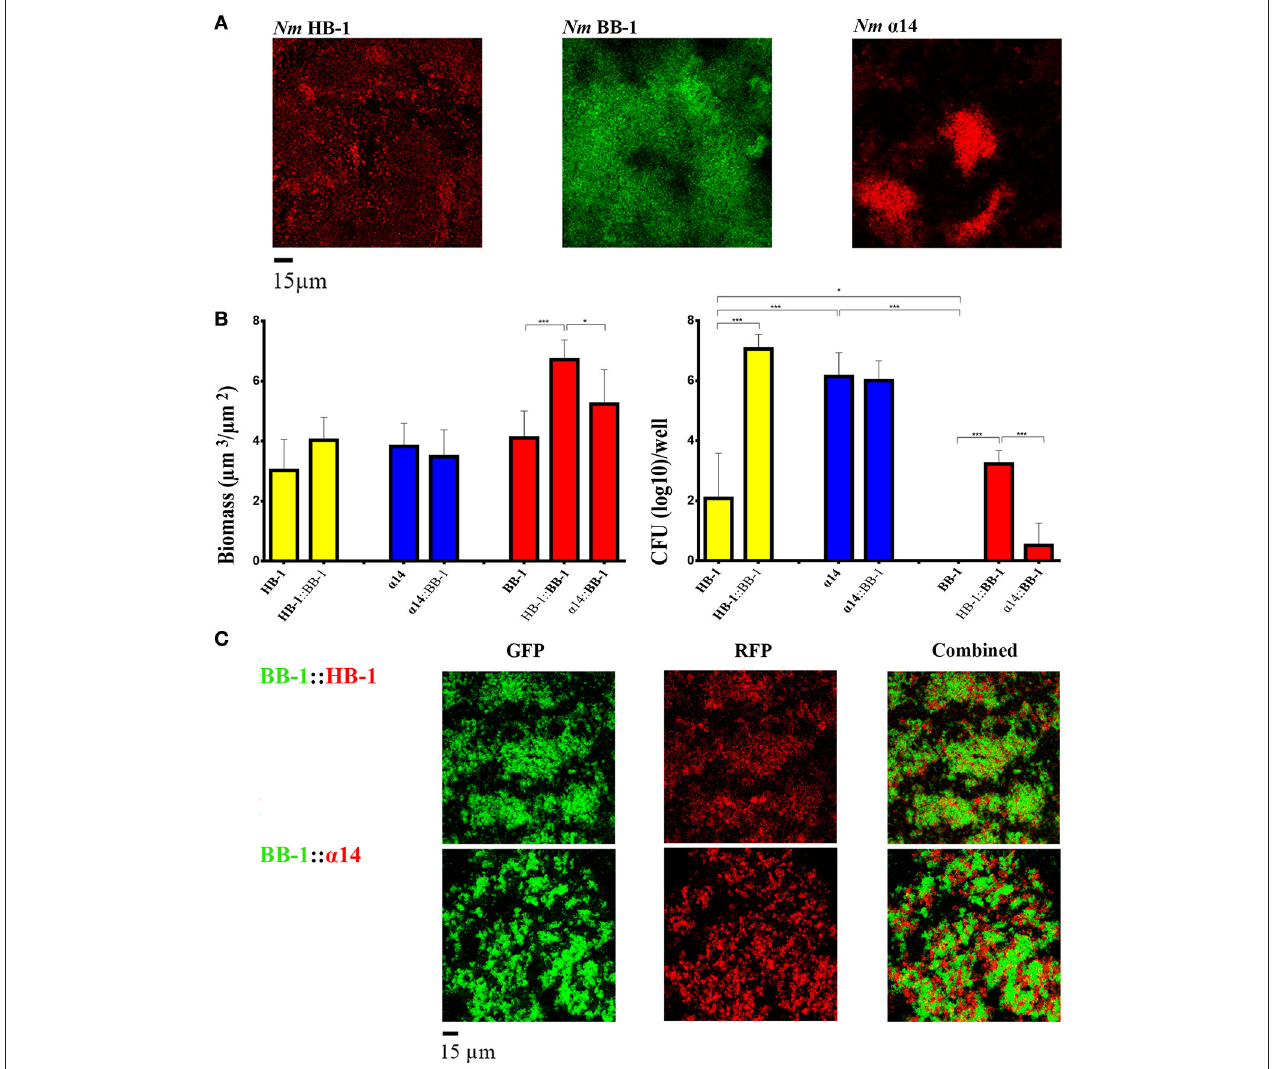
FIGURE 4 | Biofilm formation under nutrient limitation. (A) Biofilms of various strains of Nm grown on RPMI medium. (B) Biomass (left panel) and CFU (right panel) in biofilms were calculated for each strain in single- and dual-strain biofilms as in Figure 3 . The strains present in the consortium are shown at the bottom of each panel. The data shown are for the strain indicated in bold. Statistically significant differences are marked with one asterisk ( P < 0.05) or with three asterisks ( P < 0.0005) (unpaired t -test). (C) Interbacterial interactions in dual-strain biofilms constituted of BB-1 and HB-1 or α 14.